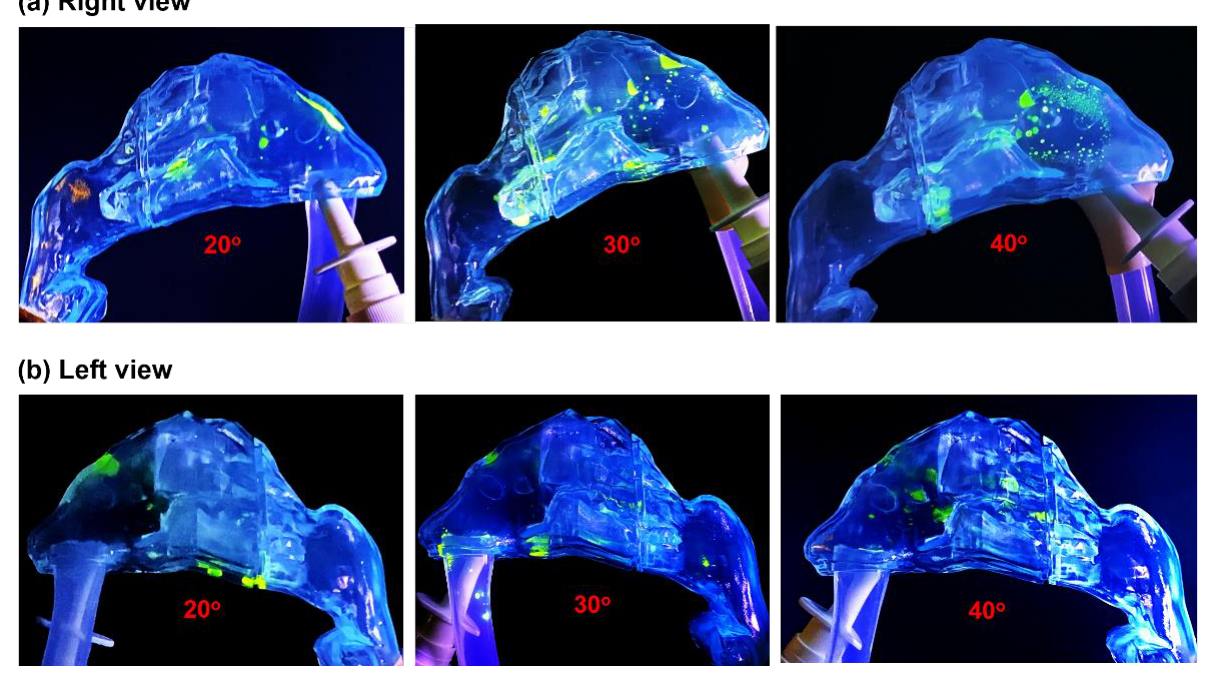
Figure 4. Nasal spray deposition distribution using the bidirectional delivery method for different administration angles: 20°, 30°, and 40°. ( a ) Right view and ( b ) left view. Enhanced deposition in the turbinate region was observed with an administration angle of 30°.